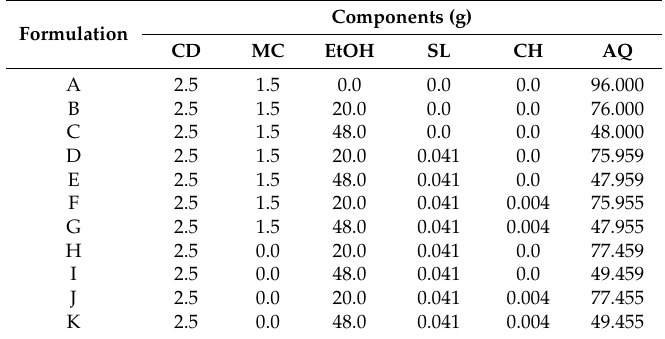
Table 1. Qualitative-quantitative compositions of the obtained